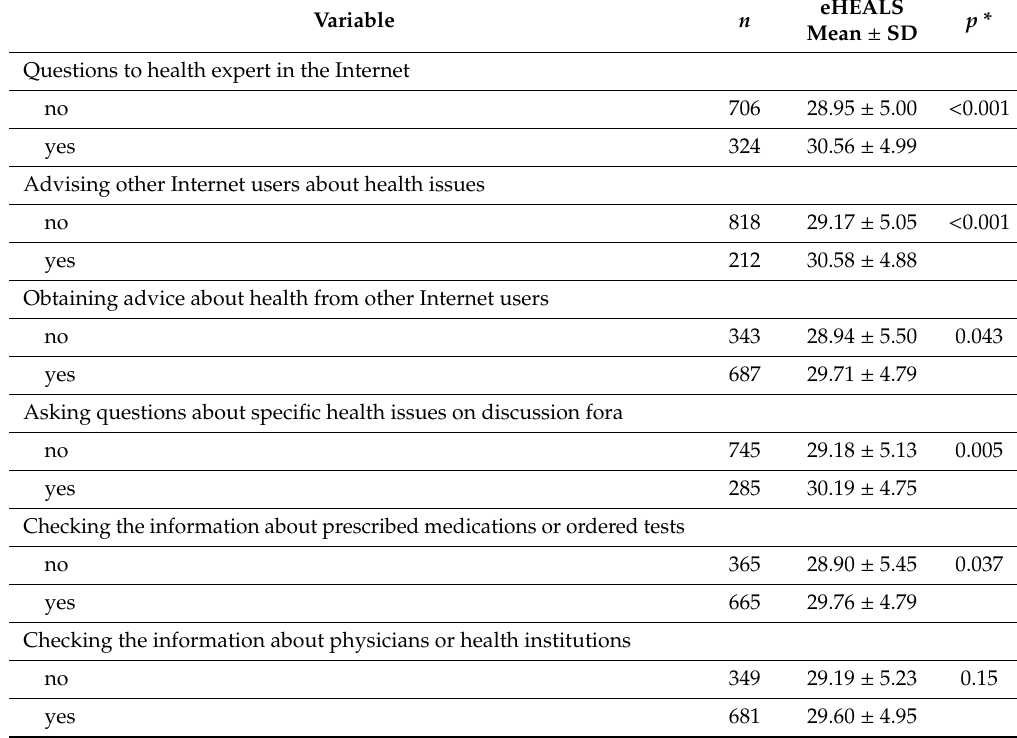
Table 3. The association of ehealth literacy and health-related activities performed online (Sample No 2). Variable n